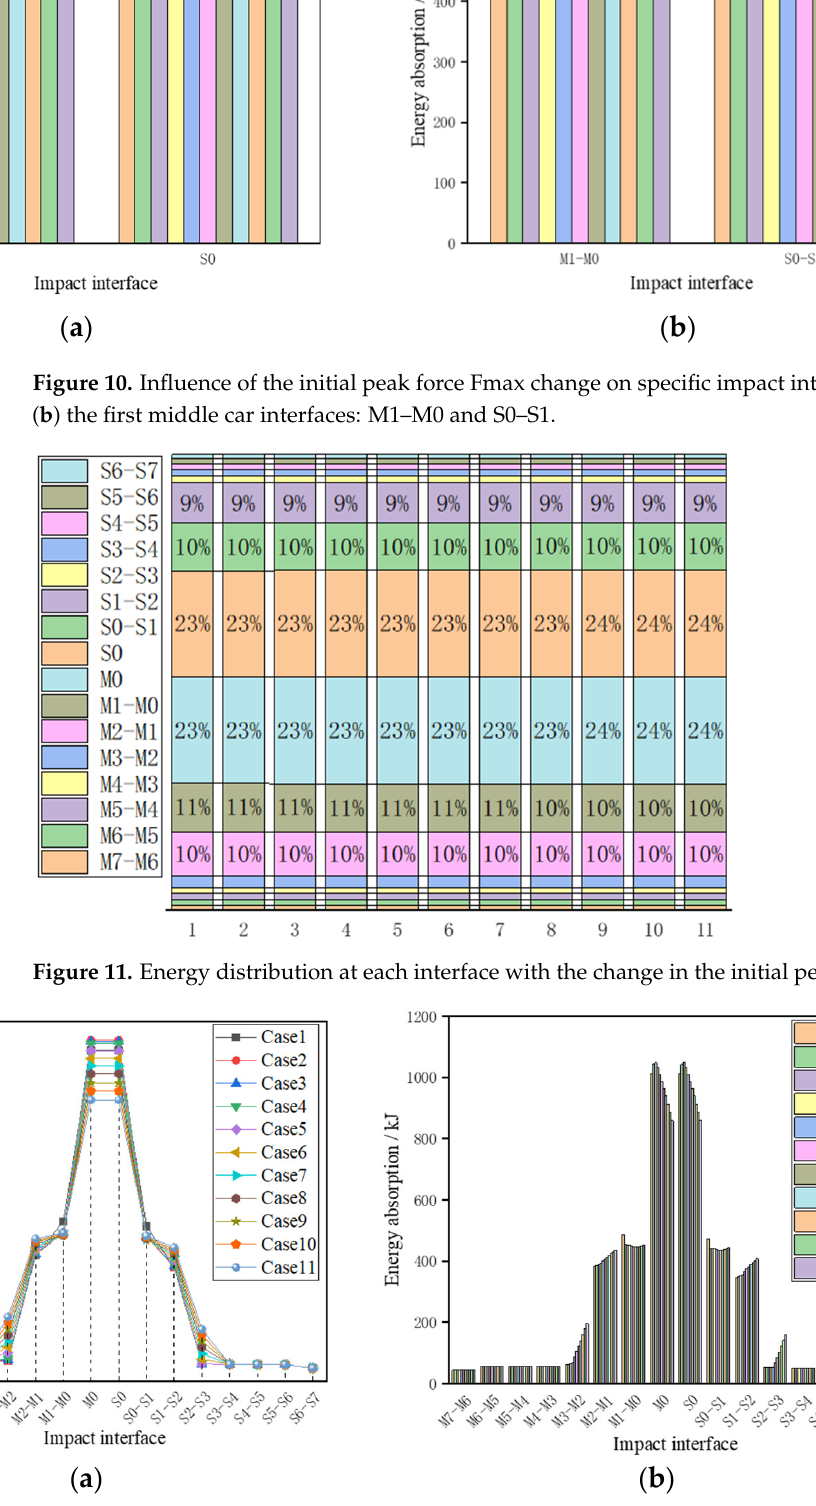
Figure 12. Influence of the platform force change on overall train collision energy: ( a ) broken line graph, ( b ) bar chart.